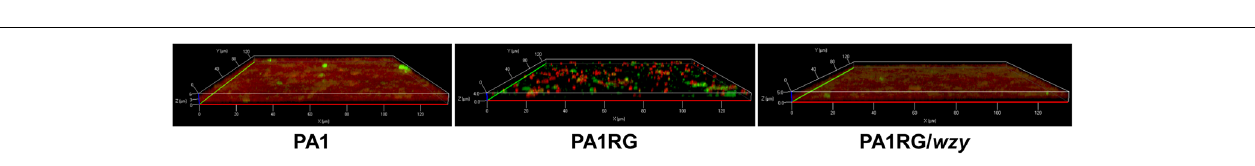
FIGURE 6 | Growth and biofilm assay. (A) Growth curves of PA1 and PA1RG that monitored every 30 min. Data represent the average of three biological replicates. (B) Microtiter dish biofilm formation assay. Data were expressed as mean ± SD from three biological replicates. ns, not significant. ∗∗∗ p < 0.001.